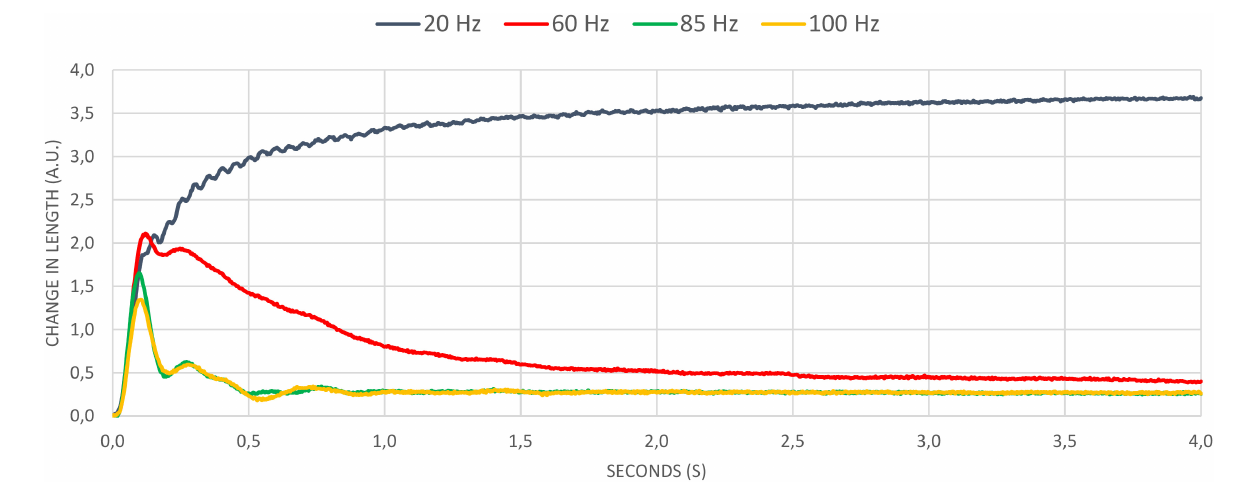
FIGURE 2 | Mean values of all